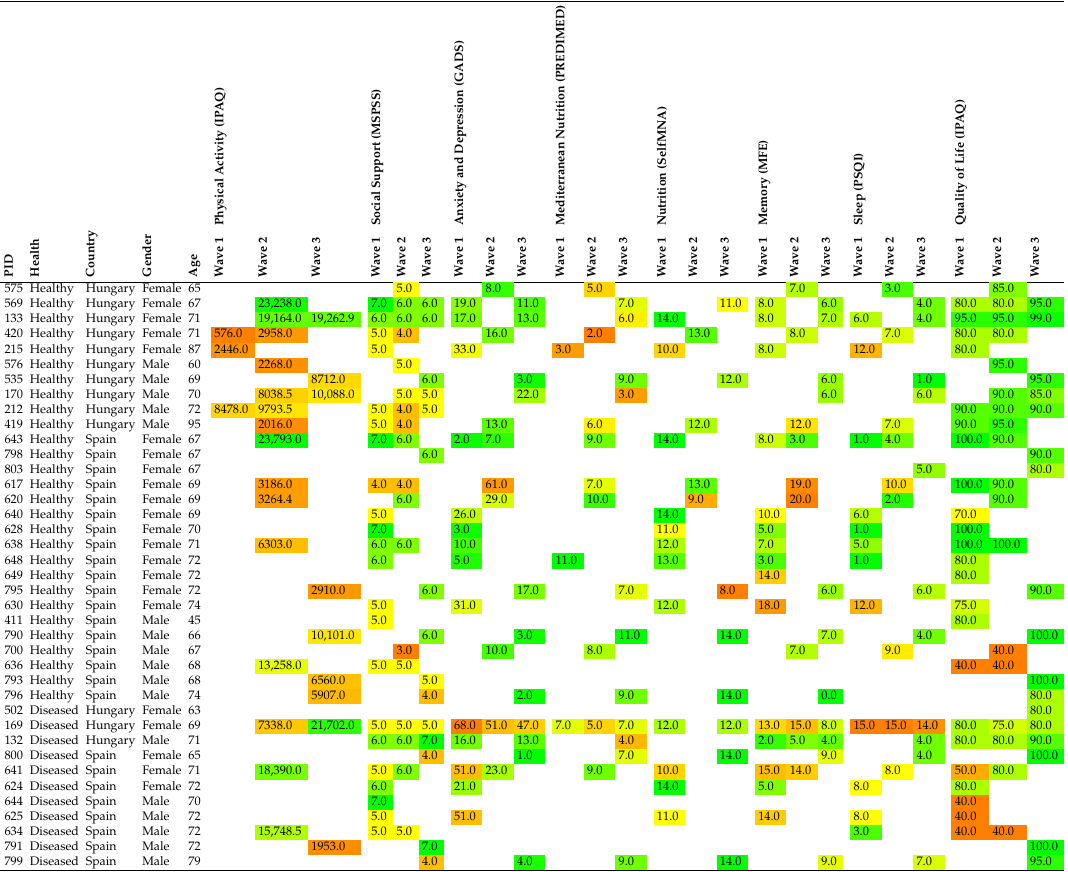
Color coding: from orange (worse score) to yellow to green